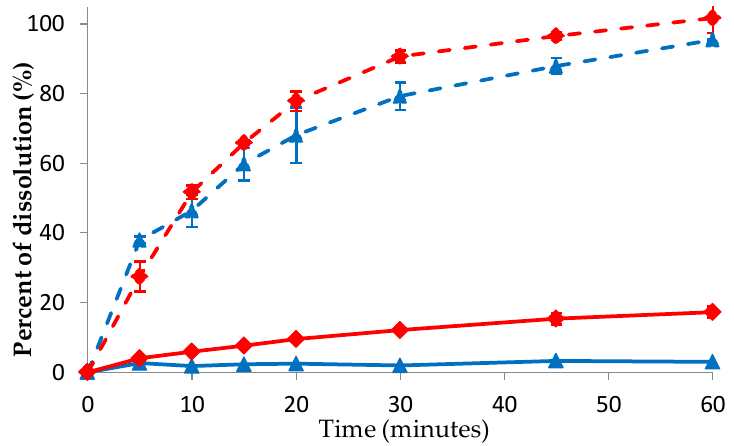
Figure 10. Powder dissolution profiles of pure crystalline desloratadine (DES) (blue) and co-amorphous DES–BA systems (red) in water (solid lines) and 0.1 N HCl (dashed lines) dissolution media at 37 °C.